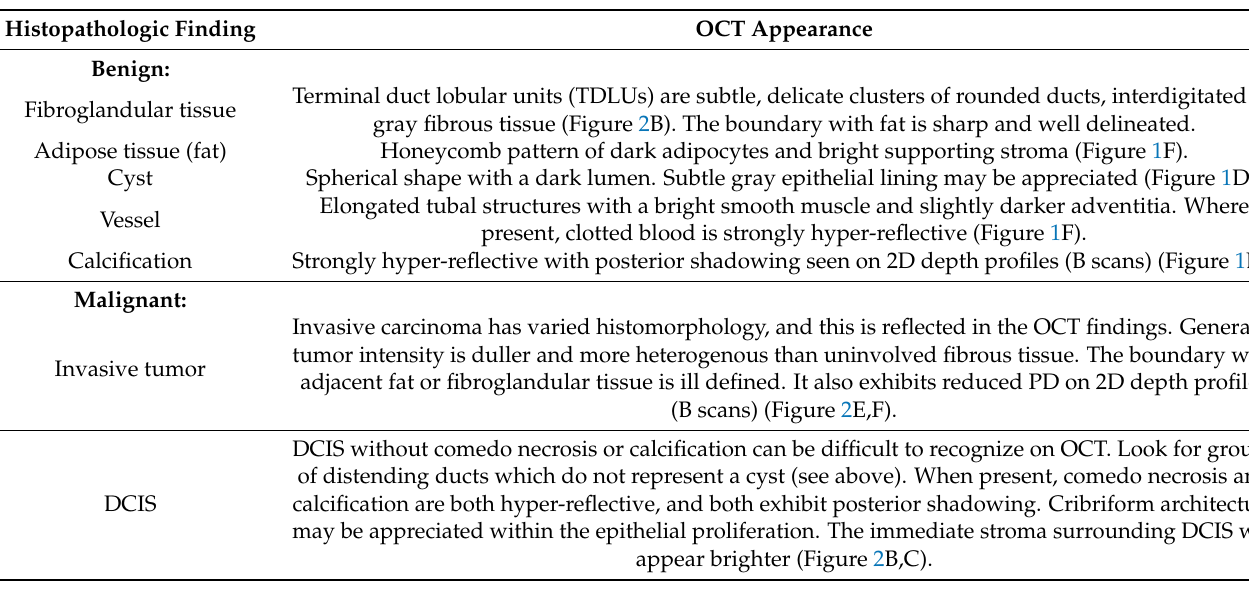
Figure 2. OCT appearance of malignant breast entities. ( A ): H & E slide showing conglomerate of cribriform DCIS with necrosis. ( B , C ): Corresponding cross-sectional ( B ) and en face ( C ) OCT images. Expanded ducts contain light gray epithelial proliferation with hyper-reflective foci of comedo necrosis (encircled). ( D ): H & E slide of invasive ductal carcinoma with pushing invasive border and clotted blood within tumor spaces. ( E , F ): Corresponding cross-sectional ( E ) and en face ( F ) OCT images. Tumor (t) shows dull texture and ill-defined boundary with adjacent fat. The hyper-reflective focus (asterisk) with posterior shadow (arrow) is likely clotted blood, as the tumor did not contain calcification on histology or radiology. ( G ): H & E slide of invasive ductal carcinoma infiltrating fat. ( H , I ): Corresponding cross-sectional ( H ) and en face ( I ) OCT images. Unlike normal fibrous tissue, the delineation between tumor (t) and fat is ill defined. Notice in 2H the irregular attenuation pattern at the lower limit of the image. Table 2. OCT Features of Breast Histology.